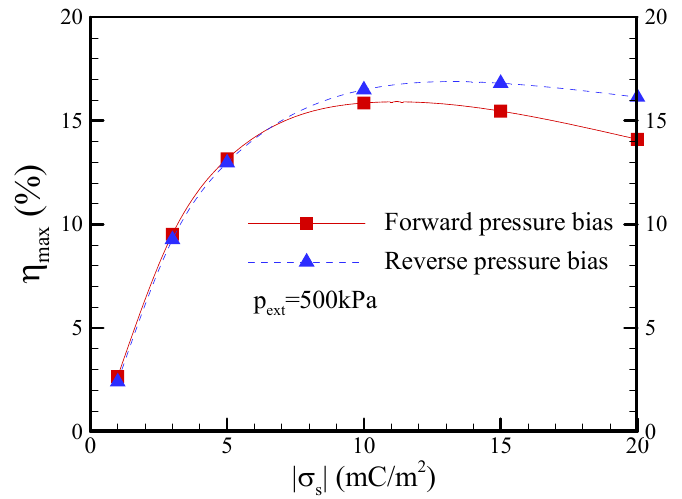
Figure 14. Plots of the maximum conversion efficiency ( η max ) as a function of the surface charge density under the conditions of c 0 = 1 mM and p ext = 500 kPa. Note that θ = 1.2 ◦ and b = 20 nm.